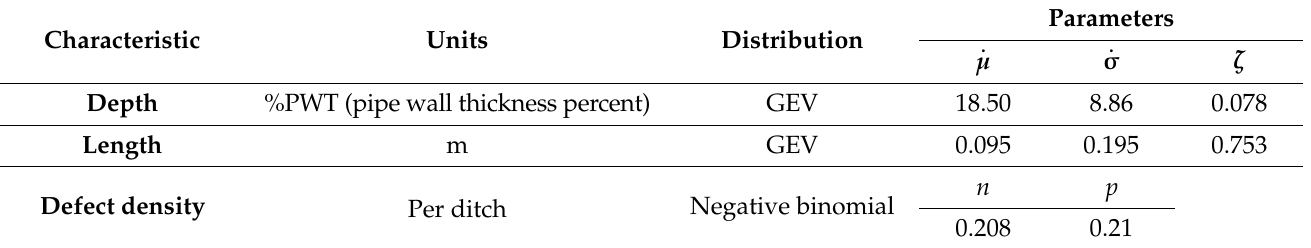
Table 3. Parameters of the fitted distributions for corrosion defect depth, length, and density of defects in the zone studied in Mexico